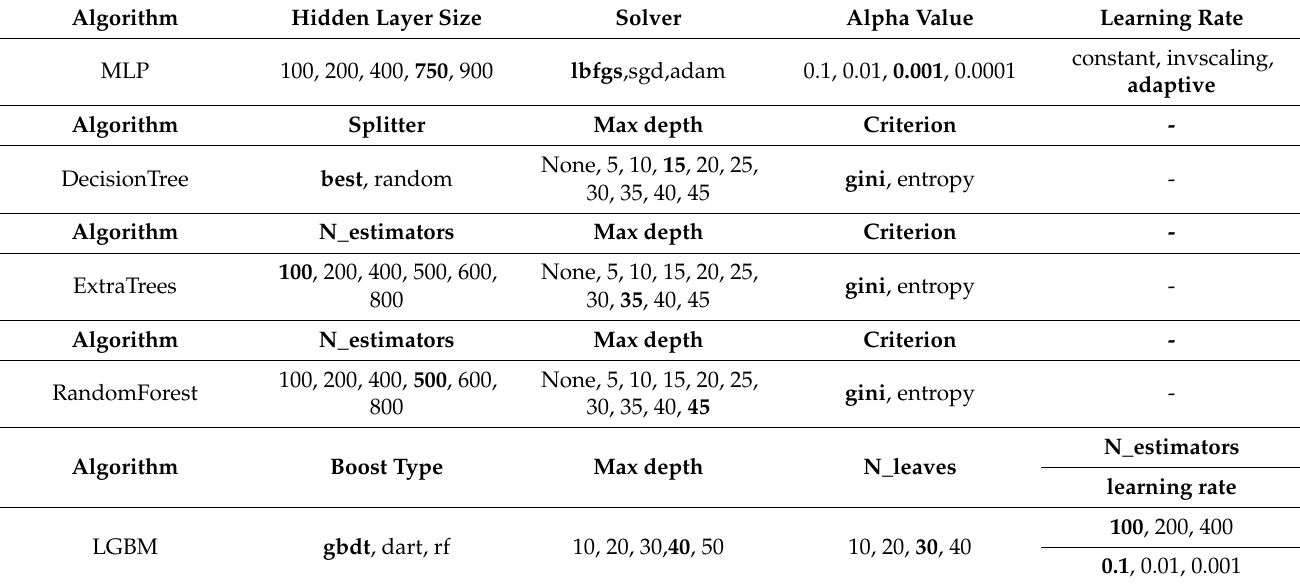
Table 2. Grid test classifiers’ parameters and optimal parameters (in bold), in terms of F1